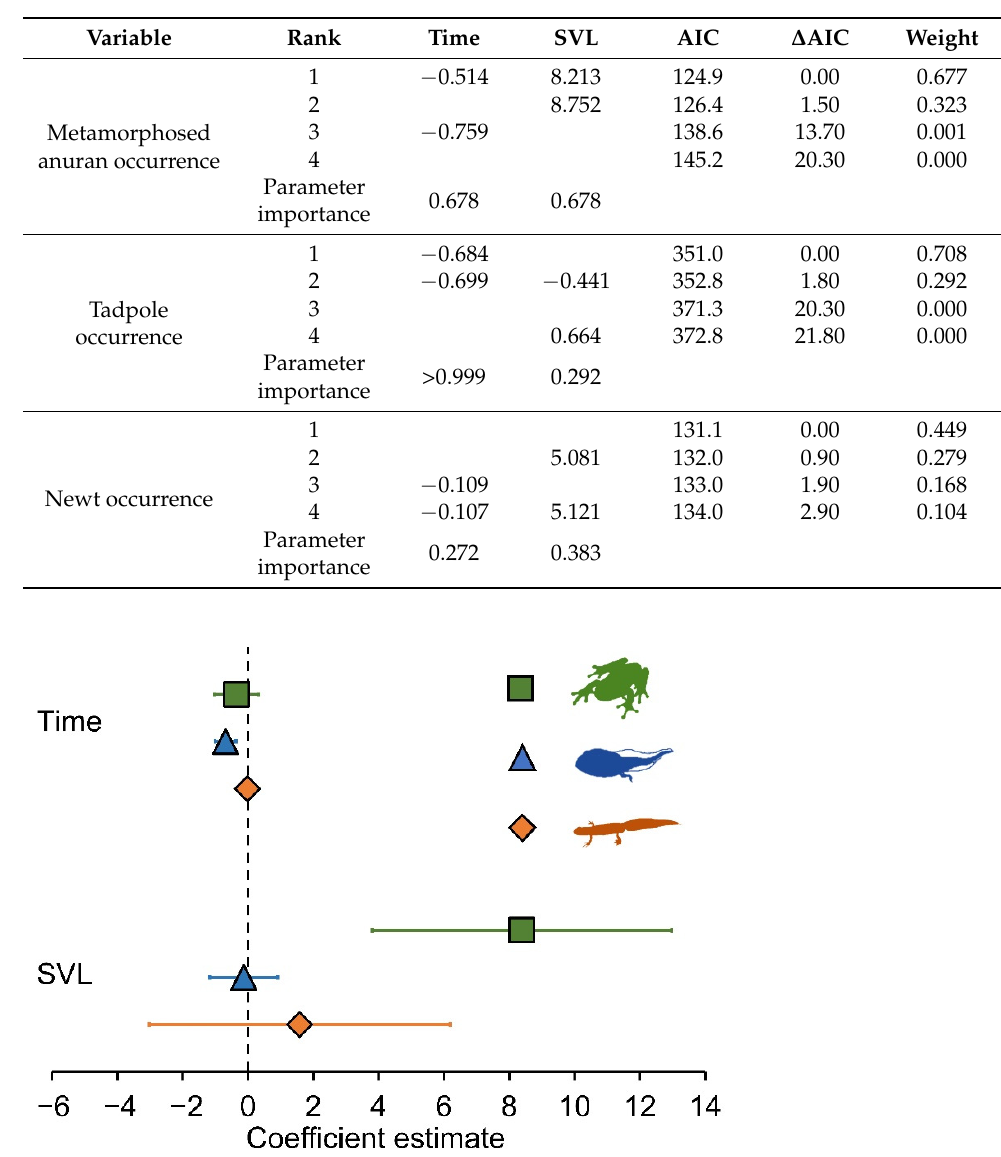
Table 1. Comparison of models explaining the occurrence of amphibians in stomach contents. Models (all shown) are ranked from the best to the worst according to AIC. Explanatory parameters were